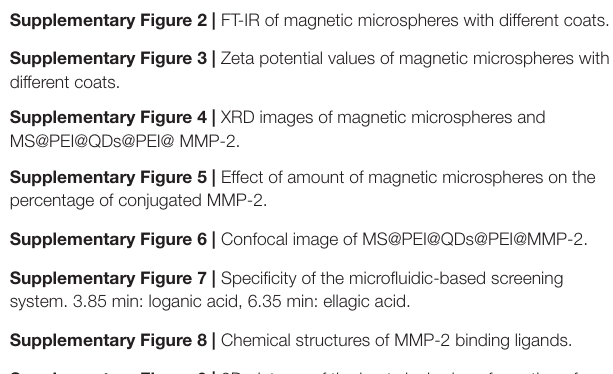
Supplementary Figure 1 | Homemade microfluidic system and microfluidic chip. Supplementary Figure 2 | FT-IR of magnetic microspheres with different coats. Supplementary Figure 3 | Zeta potential values of magnetic microspheres with different coats. Supplementary Figure 4 | XRD images of magnetic microspheres and MS@PEI@QDs@PEI@ MMP-2. Supplementary Figure 5 | Effect of amount of magnetic microspheres on the percentage of conjugated MMP-2. Supplementary Figure 6 | Confocal image of MS@PEI@QDs@PEI@MMP-2. Supplementary Figure 7 | Specificity of the microfluidic-based screening system. 3.85 min: loganic acid, 6.35 min: ellagic acid. Supplementary Figure 8 | Chemical structures of MMP-2 binding ligands. Supplementary Figure 9 | 3D pictures of the best-docked conformation of MMP2-rosamultin, MMP2-corilagin, and MMP2-kajiichigoside F1